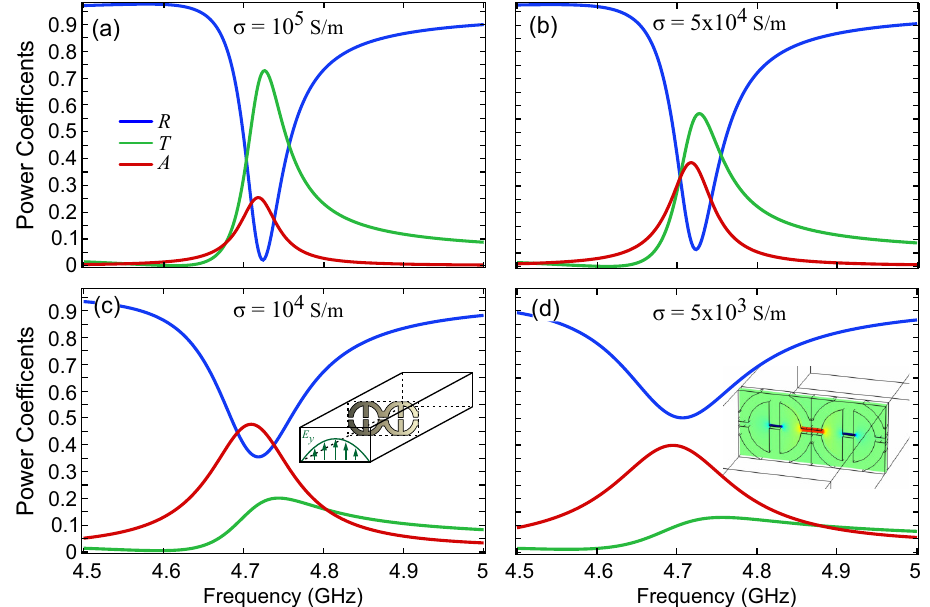
Figure 4. Simulations of the 3D-printed conductive unit cells within the WR-187 rectangular waveg- uide. The reflection ( R = | S 11 | 2 ), transmission ( T = | S 21 | 2 ) and absorption ( A = 1 − | S 11 | 2 − | S 21 | 2 ) power coefficients are plotted for different conductivities: ( a ) σ = 10 5 S/m, ( b ) σ = 5 × 10 4 S/m, ( c ) σ = 10 4 S/m and ( d ) σ = 5 × 10 3 S/m. As the conductivity is decreased, the spectral feature becomes broader and the absorption on resonance increases up to a maximum of 0.5 before starting to decrease